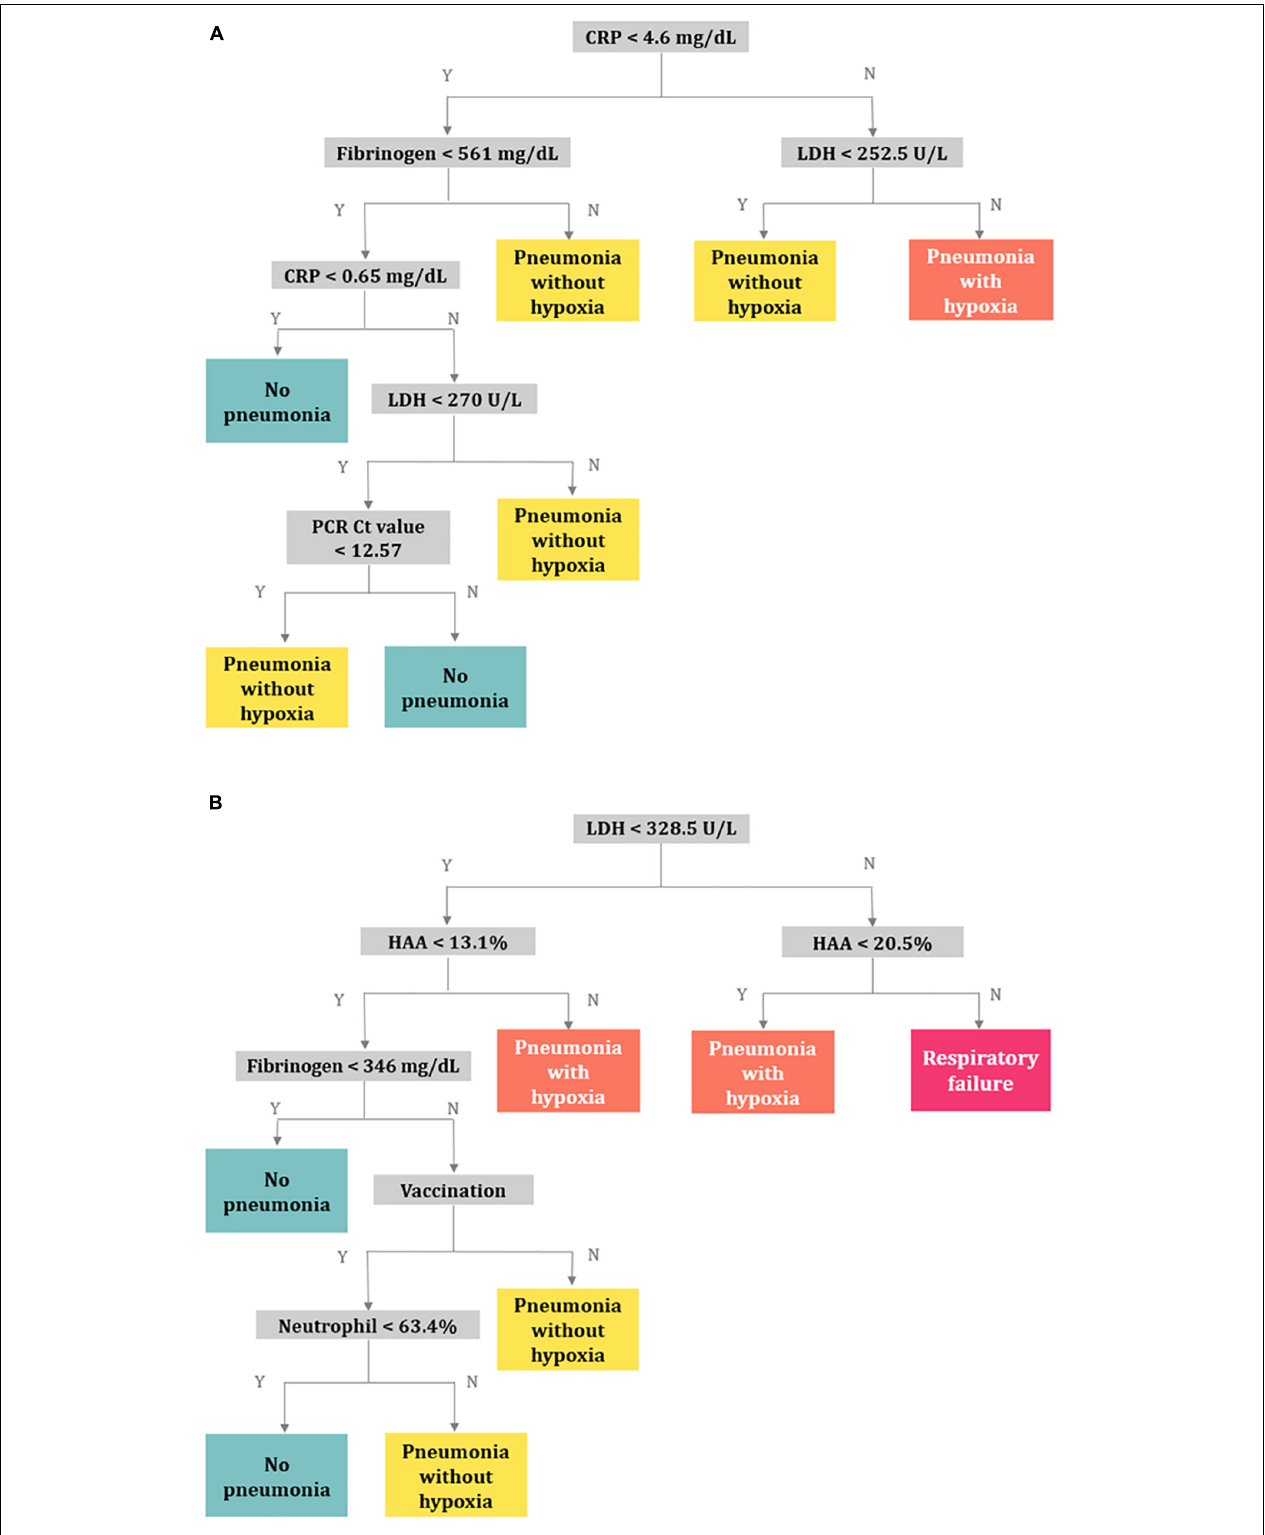
FIGURE 4 | Decision trees for predicting respiratory outcomes. (A) Model 1 using the clinical characteristics, PCR Ct values, and laboratory variables, (B) model 2 using quantitative CT parameters in addition to the variables in model 1. Abbreviation: PCR, polymerase chain reaction; Ct, cycle threshold; CT, computed tomography; CRP, C-reactive protein; LDH, lactate dehydrogenase; HAA, high-attenuation area.